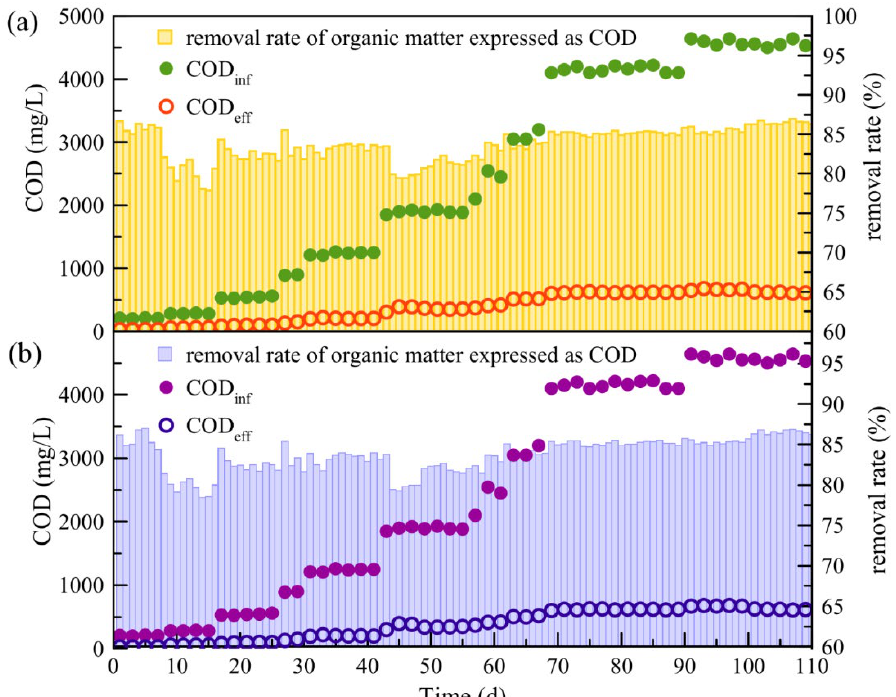
Figure 2. Removal of COD from landfill leachate by ( a ) SBBR; ( b ) SBR.